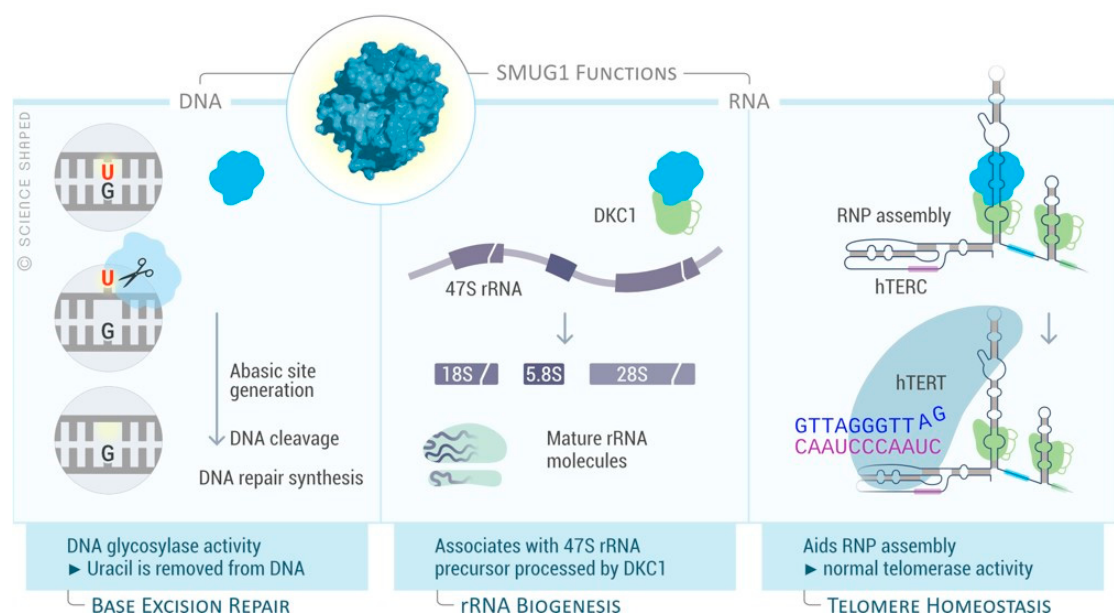
Figure 7. SMUG1 functions on DNA and RNA. SMUG1 role in DNA repair as DNA glycosylase in the base excision repair (BER) pathway and in RNA processing with functional relevance for ribosomal RNA biogenesis and telomere mainte- nance. Dyskerin 1, DKC1; human telomerase RNA component, hTERC ; human telomerase reverse transcriptase, hTERT [178].